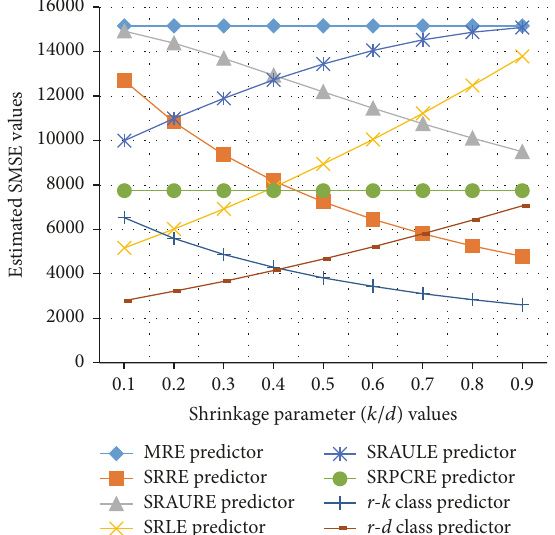
Figure 6: SMSE values of the predictors in the misspecified regression model when 𝑛 = 50 and 𝜌 = 0.999